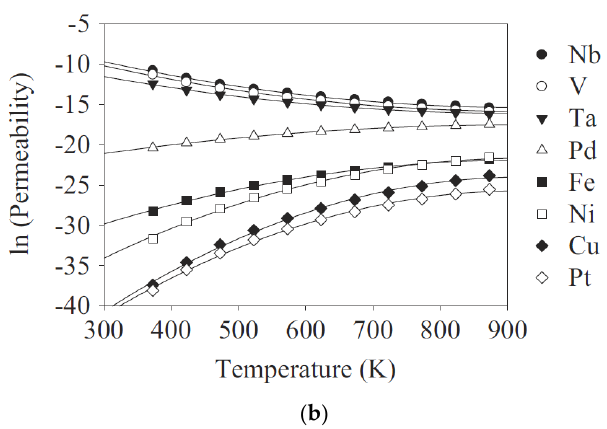
Figure 5. ( a ) The hydrogen solubility in different metals at the pressure of 1 atm at different temperatures [72] and ( b ) the hydrogen permeability in different metals at different temperatures [76]. Figure 5 a modified with permission of the authors of [72], Figure 5 b modified with permission of the authors of [76].